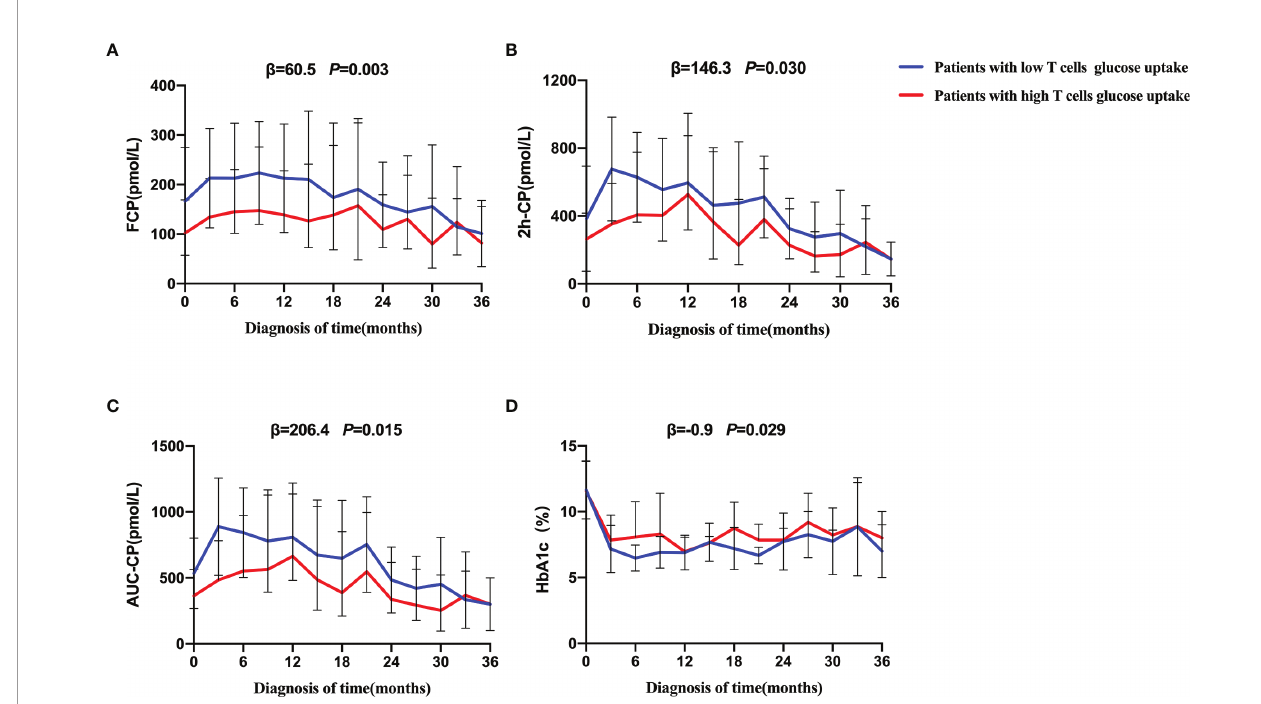
FIGURE 4 | Progression of beta-cell function and trajectory of glycemic control in T1D during the follow-up. Generalized estimated equation (GEE) analysis was used to compare the dynamic tendency of FCP (A) , 2h-CP (B) , AUC-CP (C) and HbA1c (D) levels between the two groups of patients during a 36-month follow-up period. The blue line = patients with low T cells glucose uptake, red line = patients with high T cells glucose uptake. The error bar means SD. The statistical difference between the curves of the two groups was represented by P value. The low glucose group was on average b higher than that of high glucose group over a 36-month period. FCP, Fasting C-peptide; 2h-CP, 2 hours postprandial C-peptide; AUC-CP, Area under curve of C-peptide; HbA1c, hemoglobin